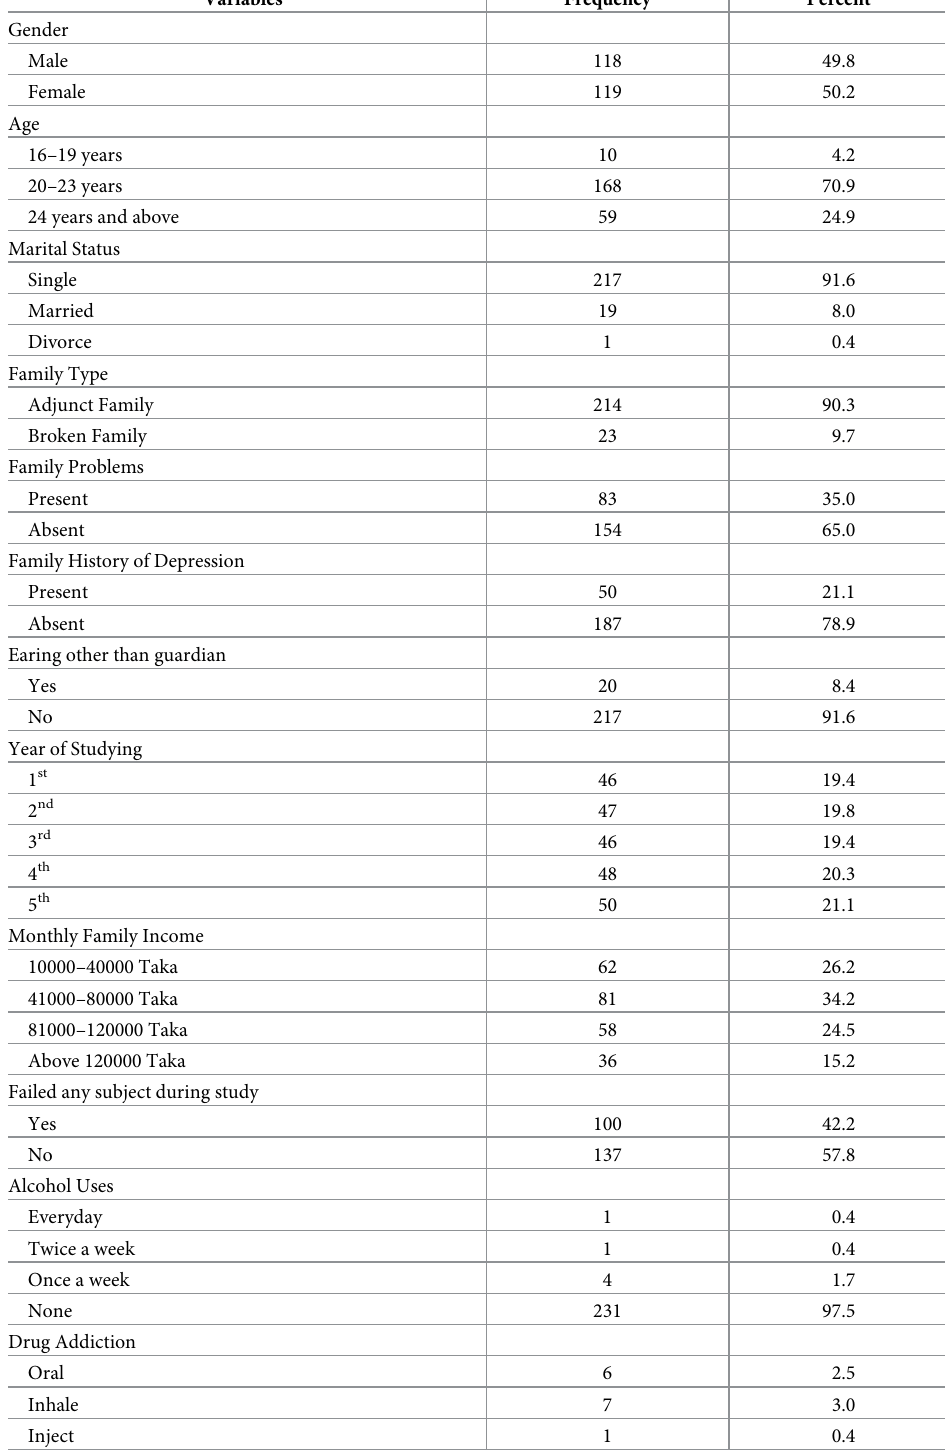
Table 1. Frequency and percentage of different variables among medical students of Enam Medical College & Hospital, Savar, Dhaka, Bangladesh, 2020 (n =